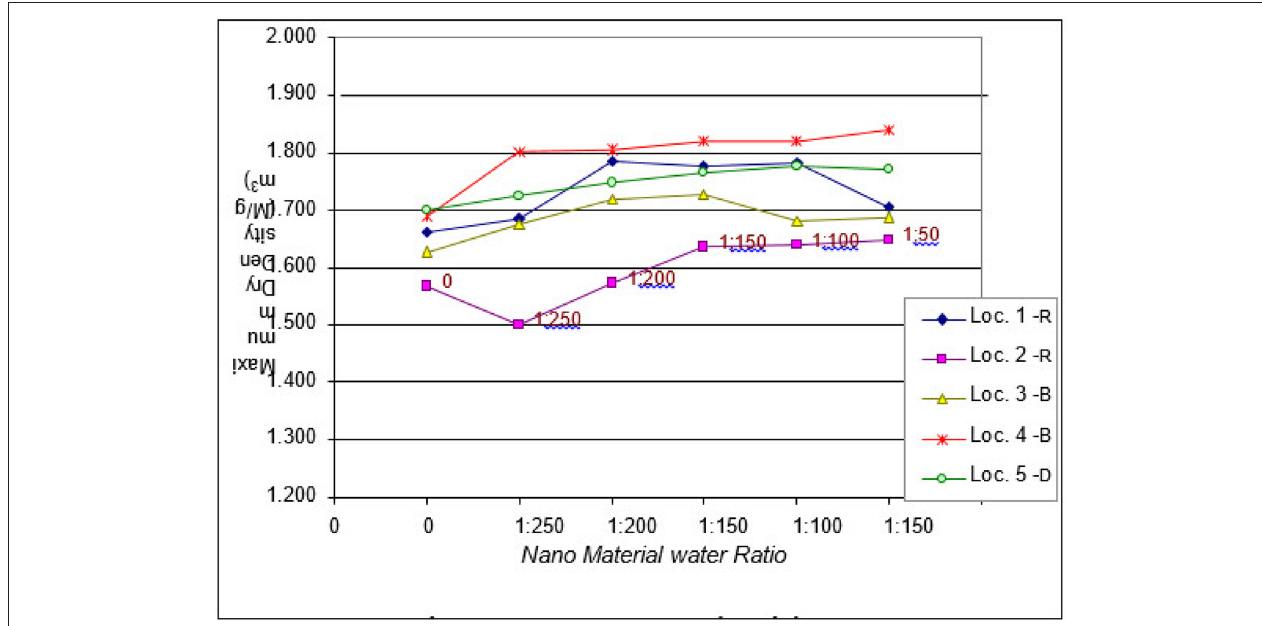
FIGURE 8 | Variation of maximum dry density with nanomaterial.